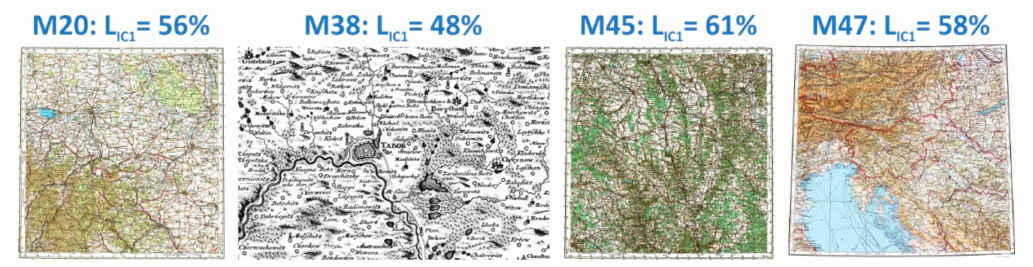
Figure 11. Examples of the maps where map load values were overestimated using IC1 metric.